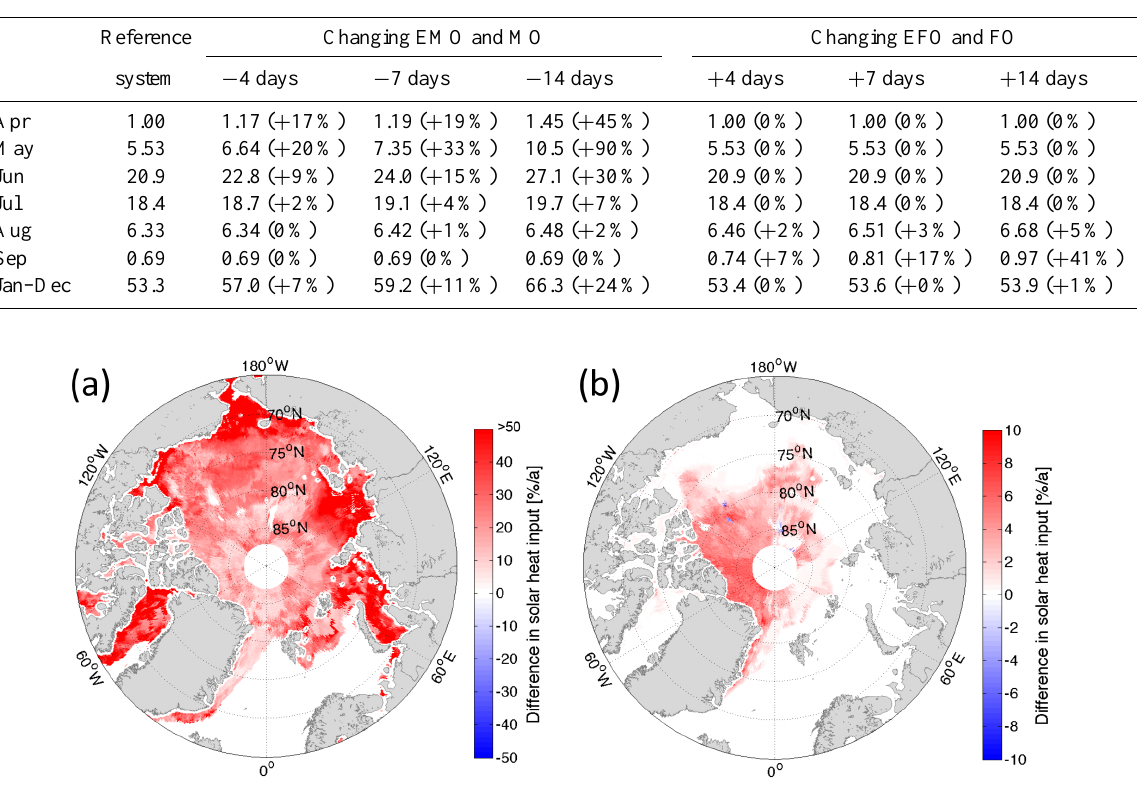
Figure 7. Changes in annual total solar heat input ( Q T (x,y) ) through sea ice in 2011, resulting from a sensitivity study assuming an extended melt season. (a) 14 days earlier early melt onset and melt onset, and (b) 14 days later early freeze onset and freeze onset than in the reference method, based on Markus et al.